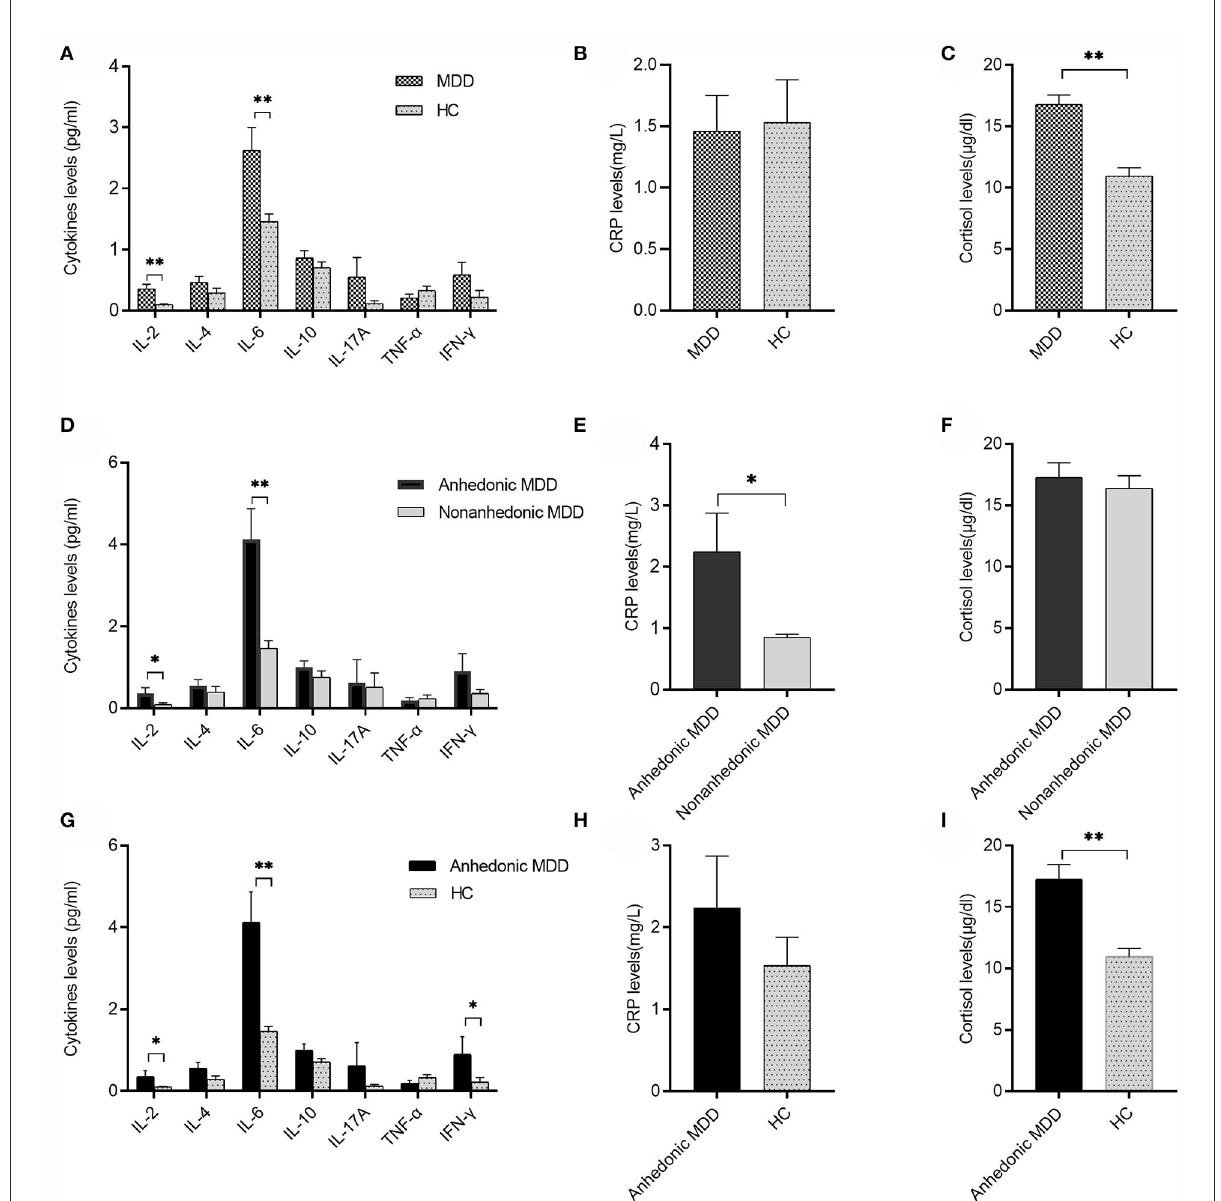
FIGURE1 Serum cytokines, C-reactive protein (CRP), and cortisol levels between major depressive disorder (MDD) and healthy control (HC) or anhedonic and nonanhedonic MDD. (A) Serum levels of IL-2 and IL-6 in the MDD group were significantly higher than the HC group ( t = 2.855, 2.922, respectively, both P < 0.01); (B) there was no significant difference in CRP levels between MDD and HC ( P > 0.05). (C) Serum levels of cortisol in the MDD group were significantly higher than those in the HC group ( t = 5.703, P < 0.001); (D) serum levels of IL-2 and IL-6 in anhedonic MDD were higher than those in nonanhedonic MDD ( t = 2.025, 3.426 respectively, P < 0.05 or 0.01); (E) serum levels of CRP in anhedonic MDD were higher than those in nonanhedonic MDD ( t = 2.476, P < 0.05); (F) no significant difference was found in serum cortisol levels between anhedonic and nonanhedonic MDD ( P > 0.05); (G) serum levels of IL-2, IL-6, and INF- γ in anhedonic MDD were significantly higher than the HC group ( t = 2.443, 3.493, 2.024, respectively, P < 0.05 or 0.01); (H) there was no significant difference in CRP levels between anhedonic MDD and HC ( P > 0.05); (I) serum levels of cortisol in anhedonic MDD were significantly higher than those in HC ( t = 4.891, P < 0.001). Mean ± SEM are shown. * P < 0.05, ** P <